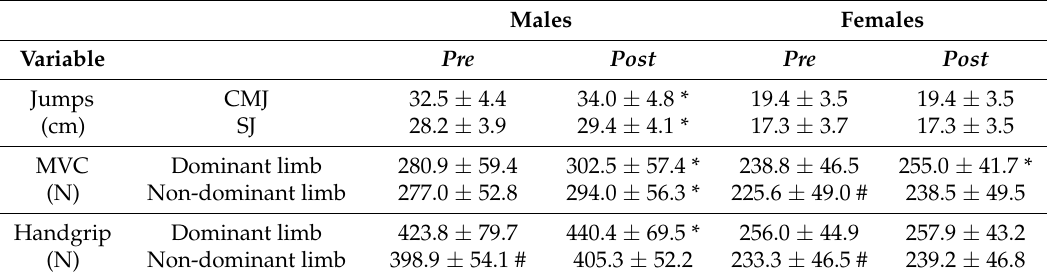
Table 2. Strength and Power Performances Before and After the 50 min Suspension Training Group Session in Male and Female